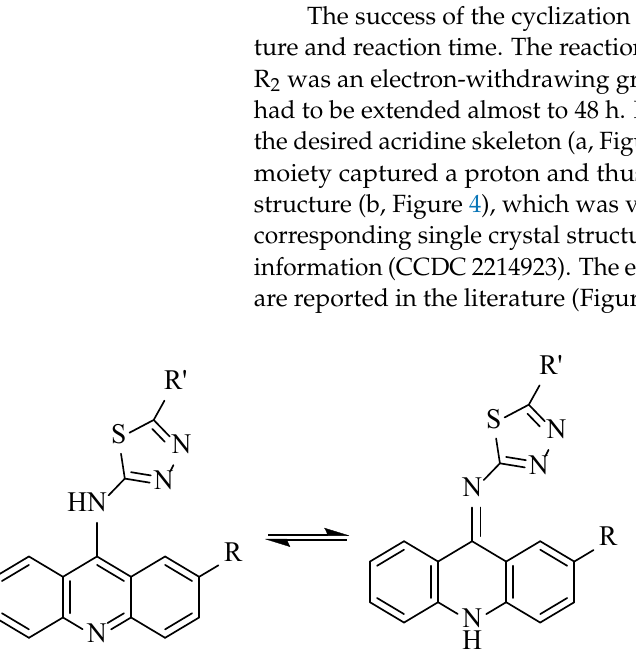
Figure 3. The molecular structure of compound 5b.